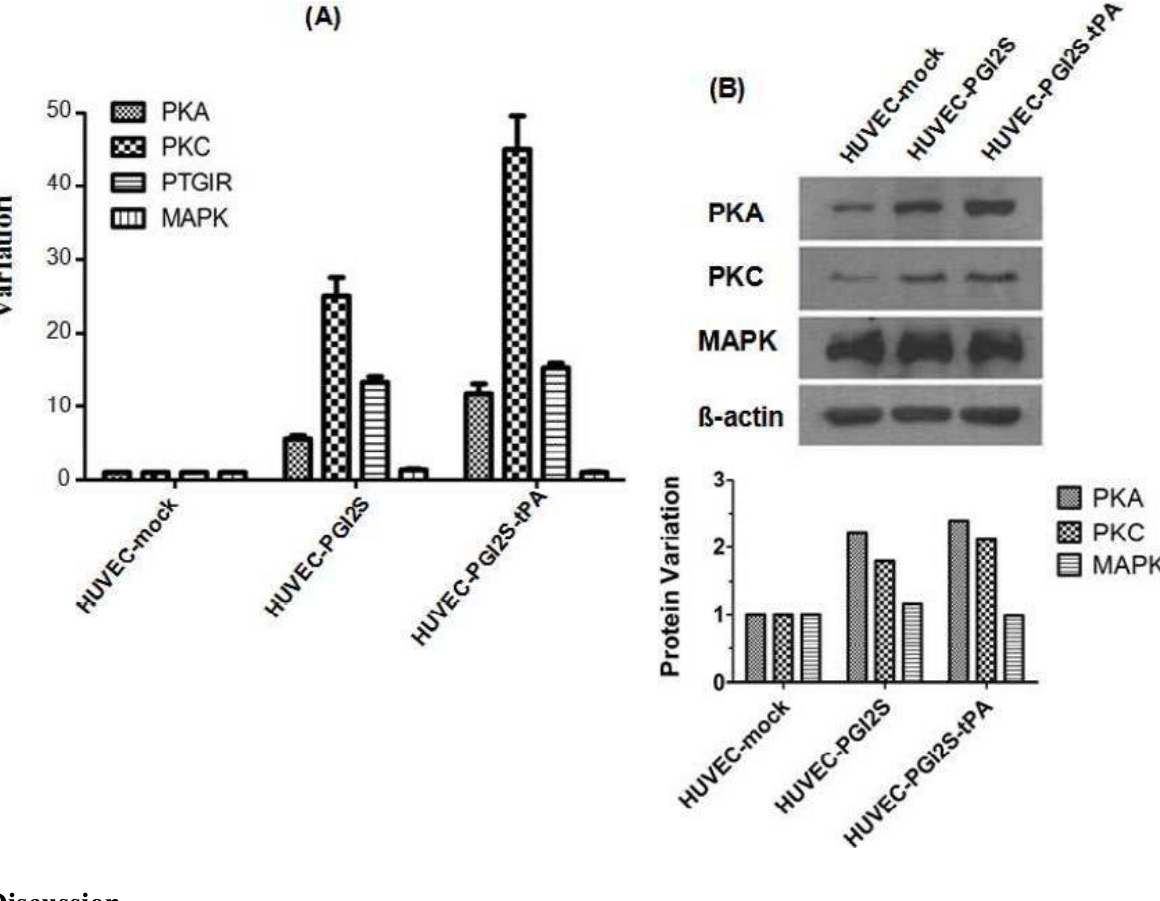
Figure 4. Vasodilation and platelet disaggregation signaling pathway factors in HUVEC-mock, HUVEC- PGI2S and HUVEC- PGI2S-tPA cell lines. ( A ) Analysis of PKA , PKC , PTGIR and MAPK mRNA expression by qRT-PCR; ( B ) Analysis of PKA, PKC and MAPK protein expression by Western blotting. All analysis were performed